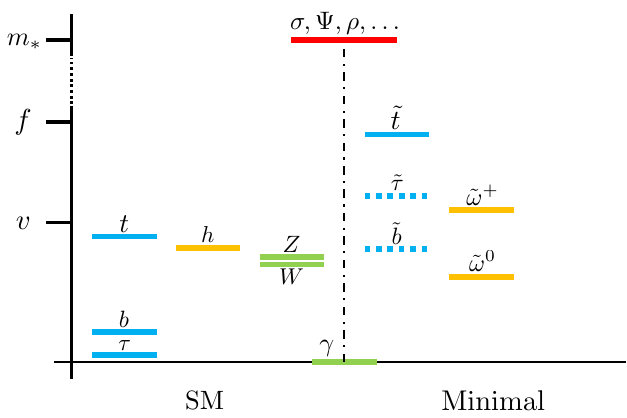
Figure 2 . Sketch of the minimal spectrum of the exceptional twin